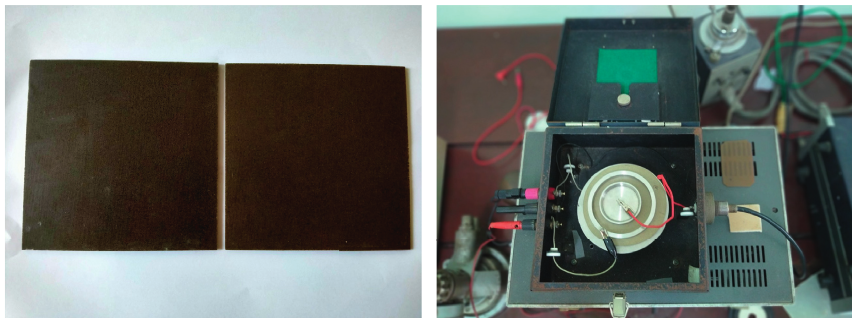
Figure 1: Specimen and puncture intensity measuring device. Table 2: Effects of epoxidized linseed oil to mechanical strength of materials. Fly ash (parts volume) Tensile strength (MPa) Flexural strength